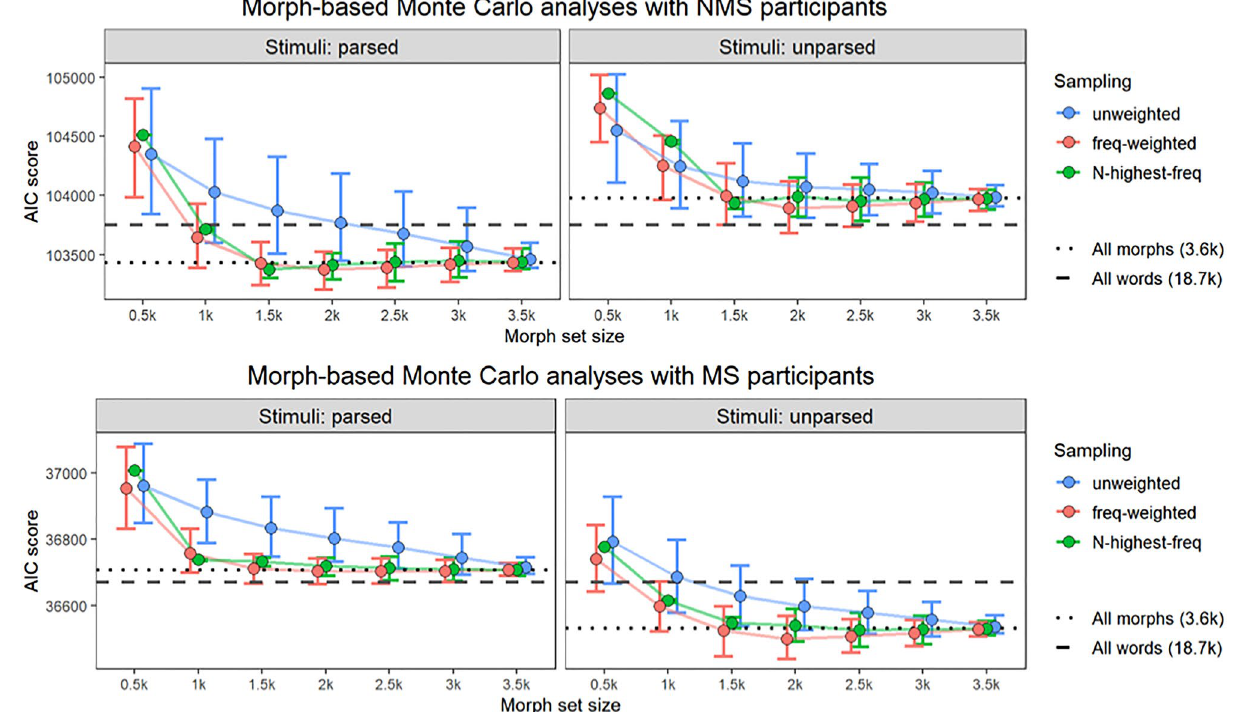
Figure 4. Monte Carlo Simulations with 1,000 samples for each size of morph set. Lower AIC score indicates greater ability to predict participants’ well-formedness ratings. The black dashed line shows the AIC score of a model that assumes phonotactic knowledge generated from the full dictionary of 18,703 words, and the black dotted line shows the AIC score of a model that assumes phonotactic knowledge generated from the full set of 3,636 morphs (assuming that participants are parsing stimuli or not, as appropriate). The error bars represent 95% bootstrap percentile